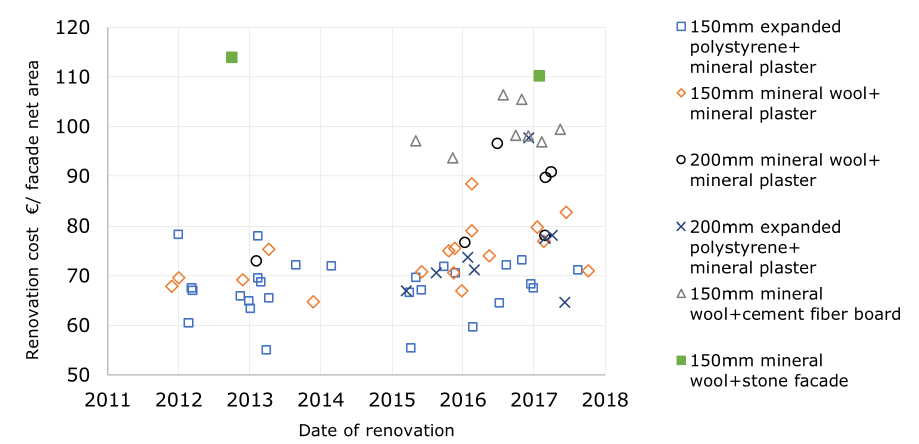
Figure 2. Common facade reconstruction